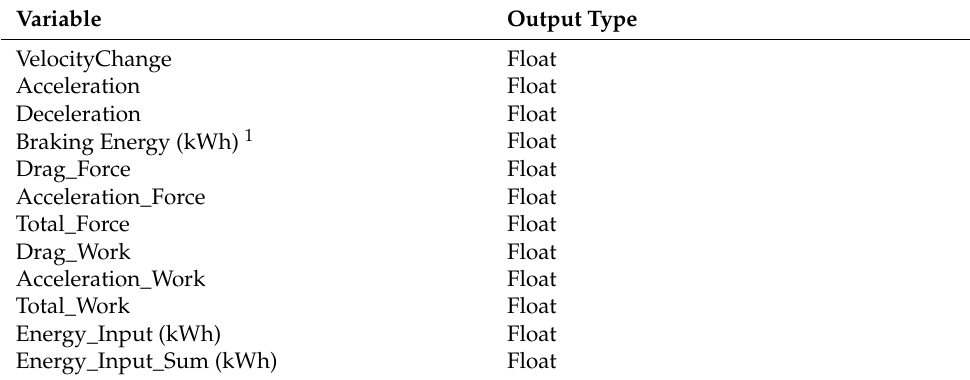
Table A1. Energy Calculation Extension notebook output data (EV/PHEV example).